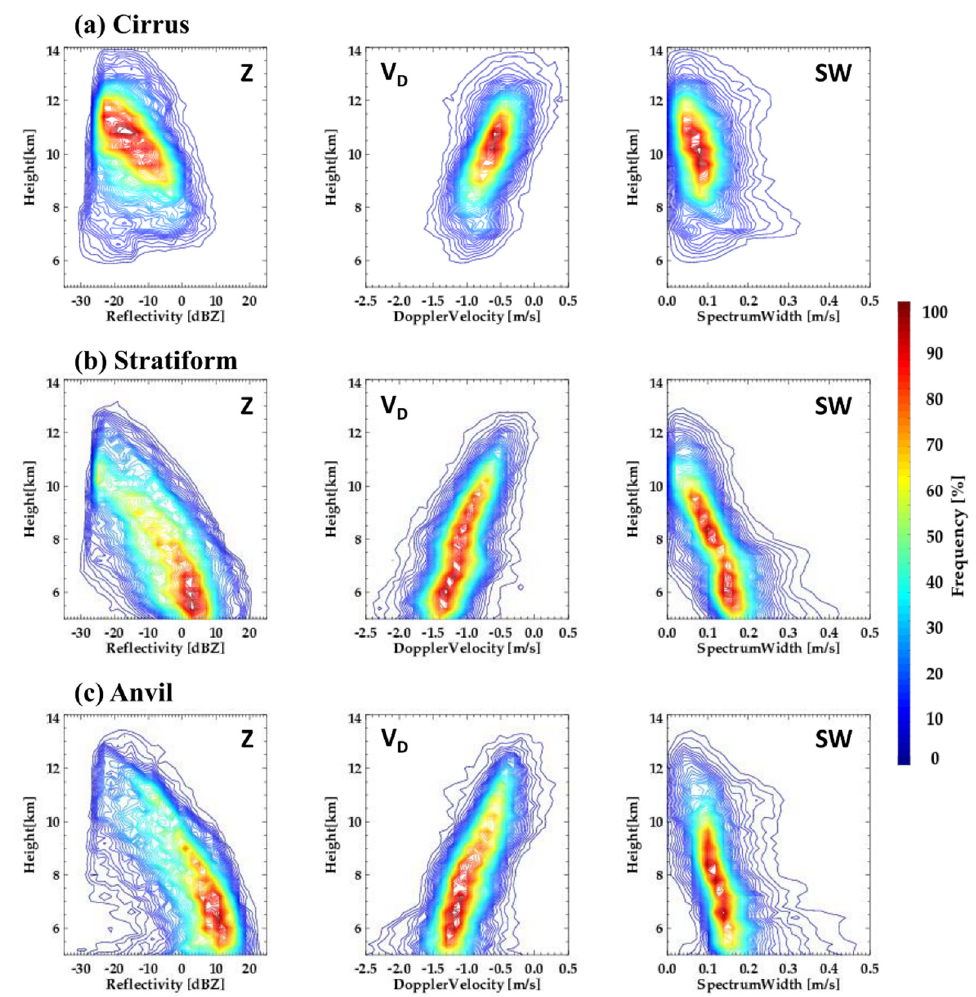
Figure 6. Contoured frequency by altitude diagrams (CFADs) of Z , V D , and SW for ice cloud types: ( a ) cirrus, ( b ) stratiform, and ( c ) anvil.